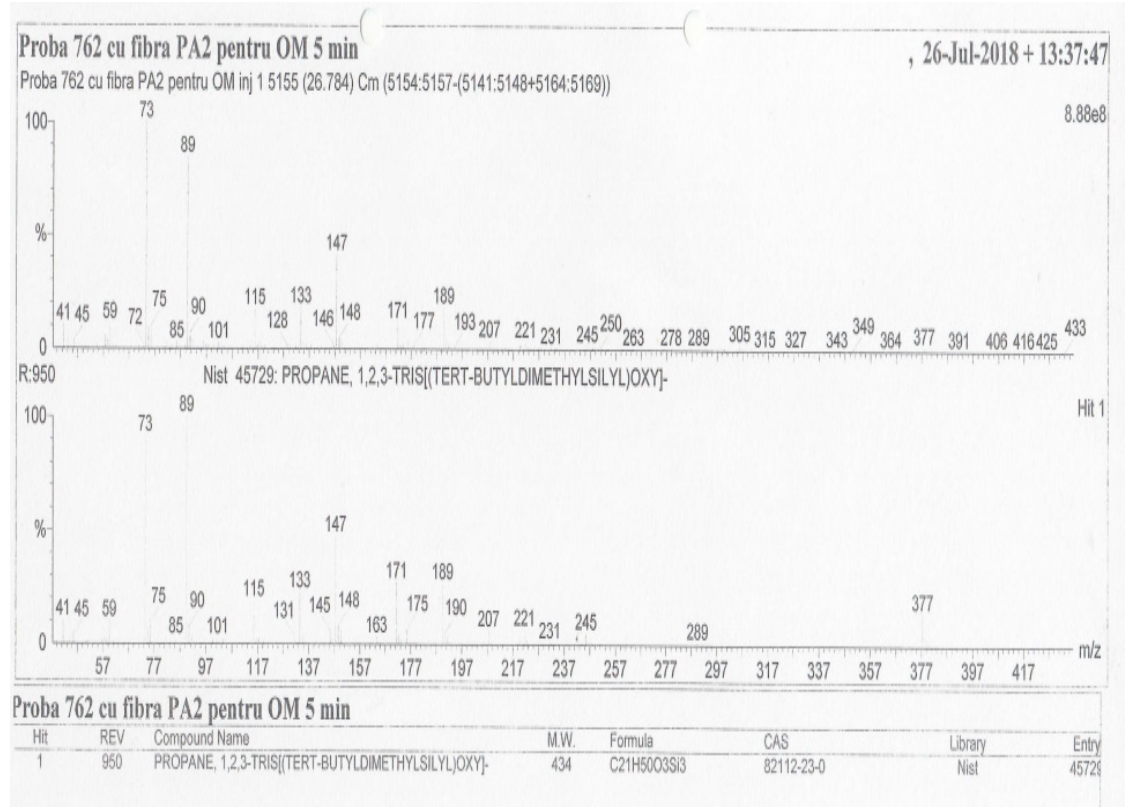
Figure 2. The identification of glycerin as tert -butyldimethylsilyl (TBDMS) ester (No. 10 in Table